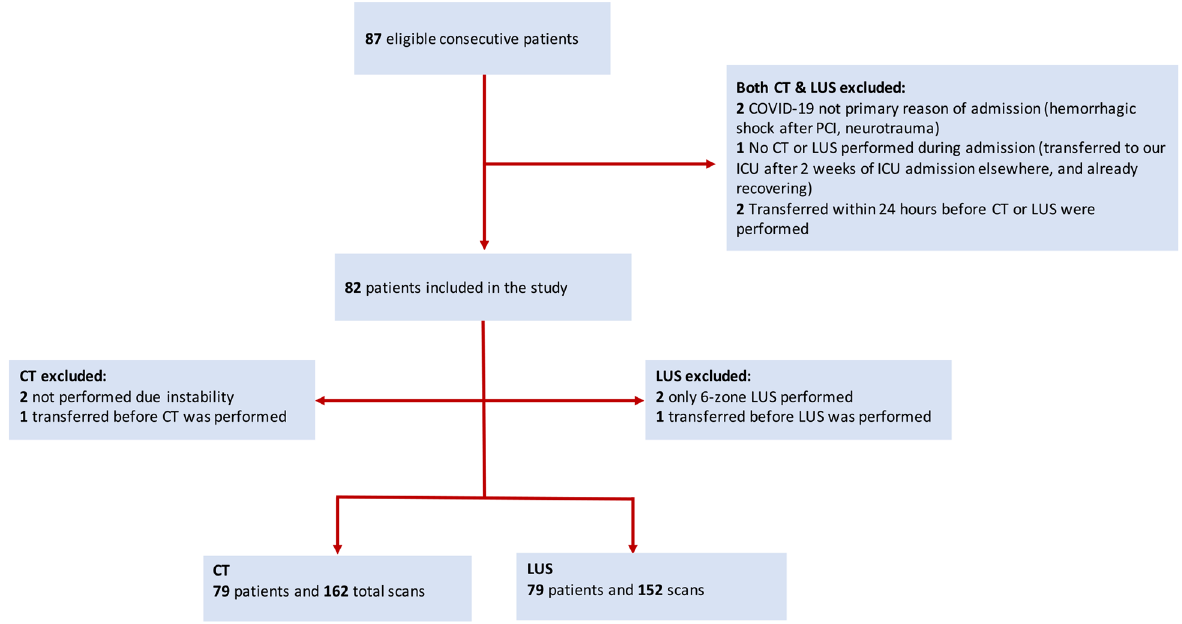
Fig. 1 Flow of patient inclusion. CT: computed tomography. LUS: lung